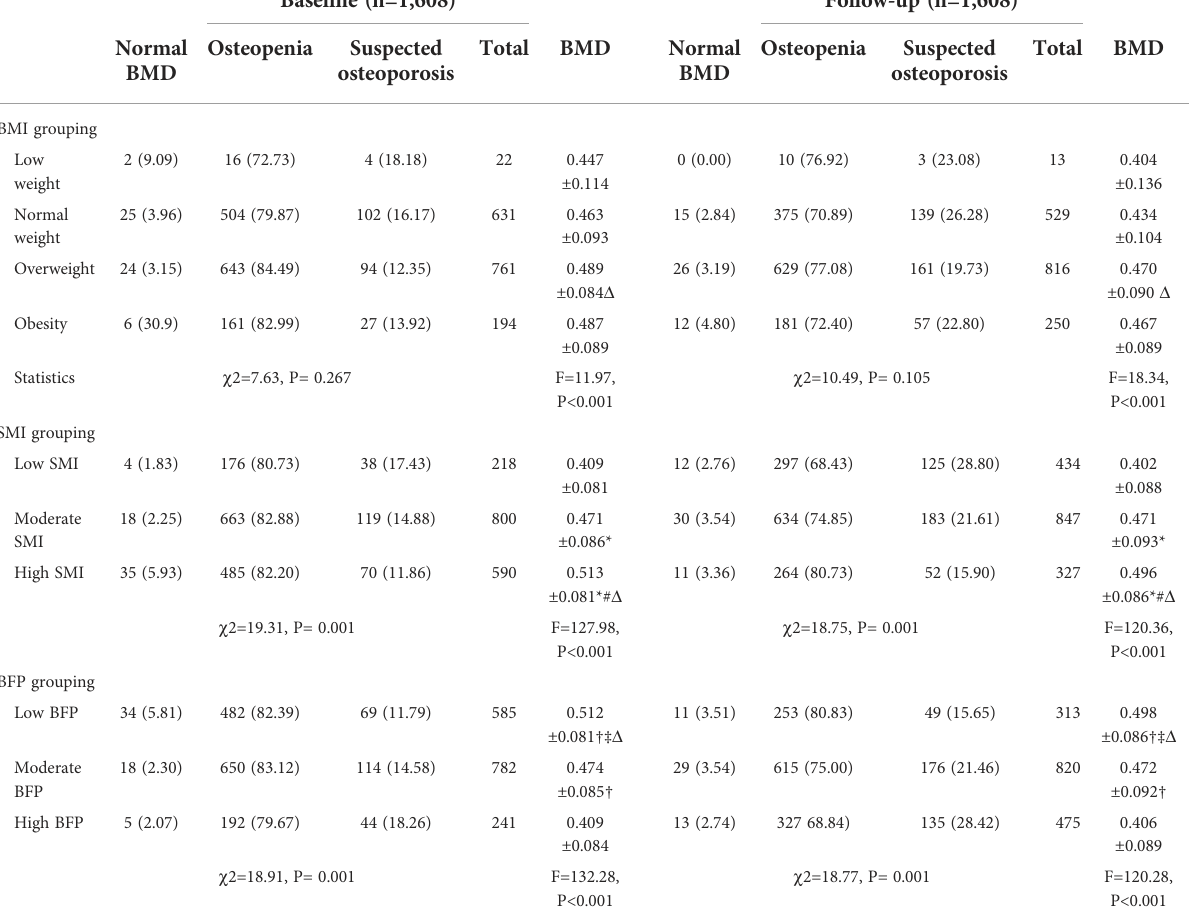
TABLE 4 The self-control study of BMD grouped by BMI, BFP and SMI.